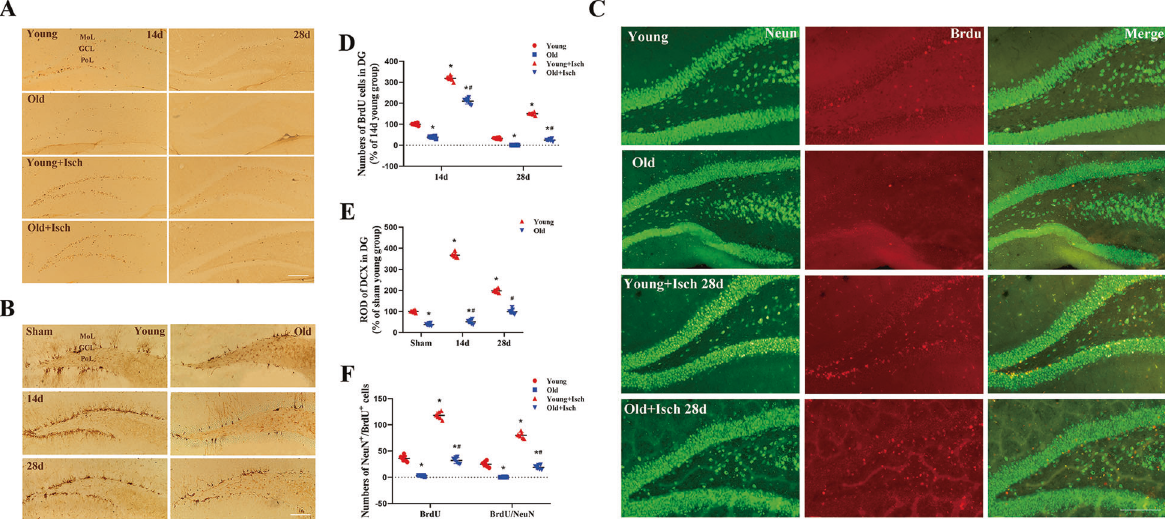
Fig. 2 Observation of cell proliferation and neuroblast differentiation. Immunohistochemistry for BrdU in the DG region of the young and old of the sham and ischemia groups ( A ). Immunohistochemistry for DCX in the DG region of the young and old of the sham and ischemia groups ( B ). Double-immuno fl uorescence staining for BrdU, NeuN, and merged images in the DG 28 days after I/R in the young and old groups ( C ). The number of BrdU cells after I/R in the young and old groups. Data are represented by the mean number of BrdU cells per animal ( D ). Relative optical density as % of DCX immunoreactive structures in the young and old groups ( E ). Quanti fi cation of BrdU/NeuN cells at 28 days post ischemia. Data are represented by the mean percentage per animal ( F ). Scale bar = 100 μ m ( n = 7 per group; * p < 0.05, signi fi cantly different from the sham young group at the same reperfusion time point, # p < 0.05, signi fi cantly different from the corresponding young I/R group at the same reperfusion time point). Bars indicate mean ±